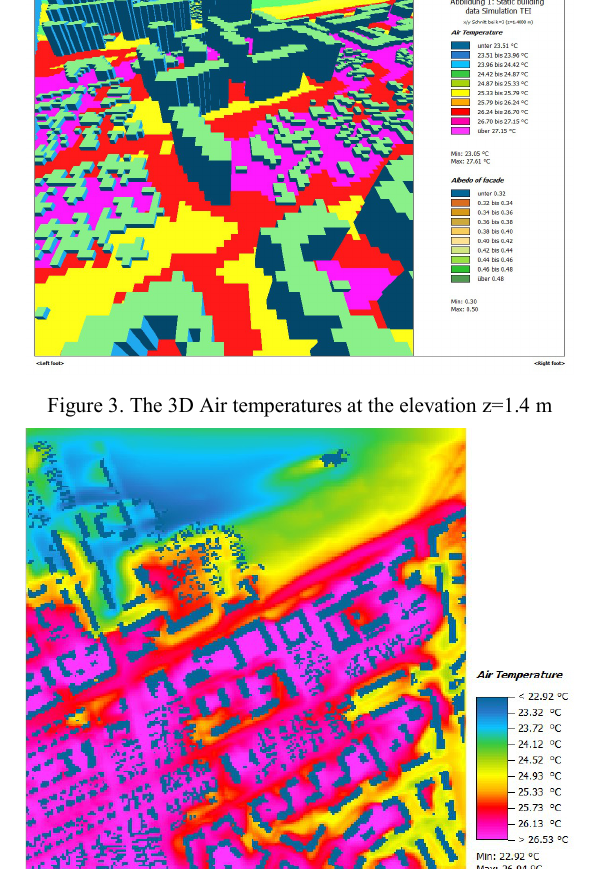
Figure 4. The 2D Air temperatures and the estimated urban